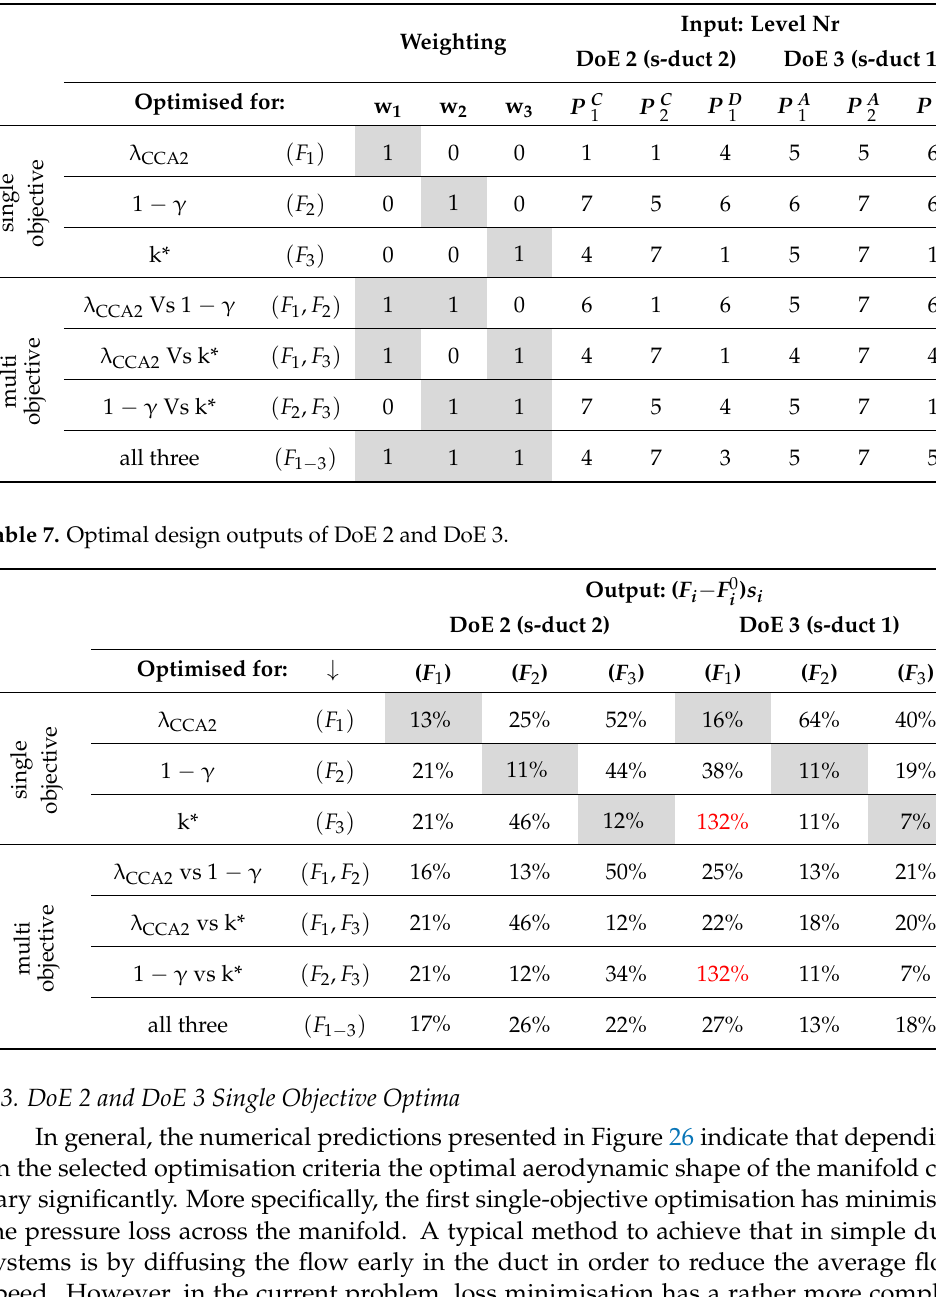
Table 6. Weighting and input variables for optimal designs of DoE 2 and DoE 3.